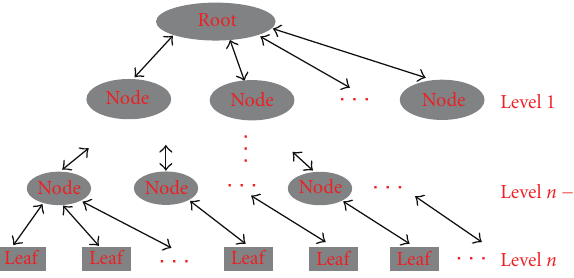
Figure 4: Topological structure of representing a